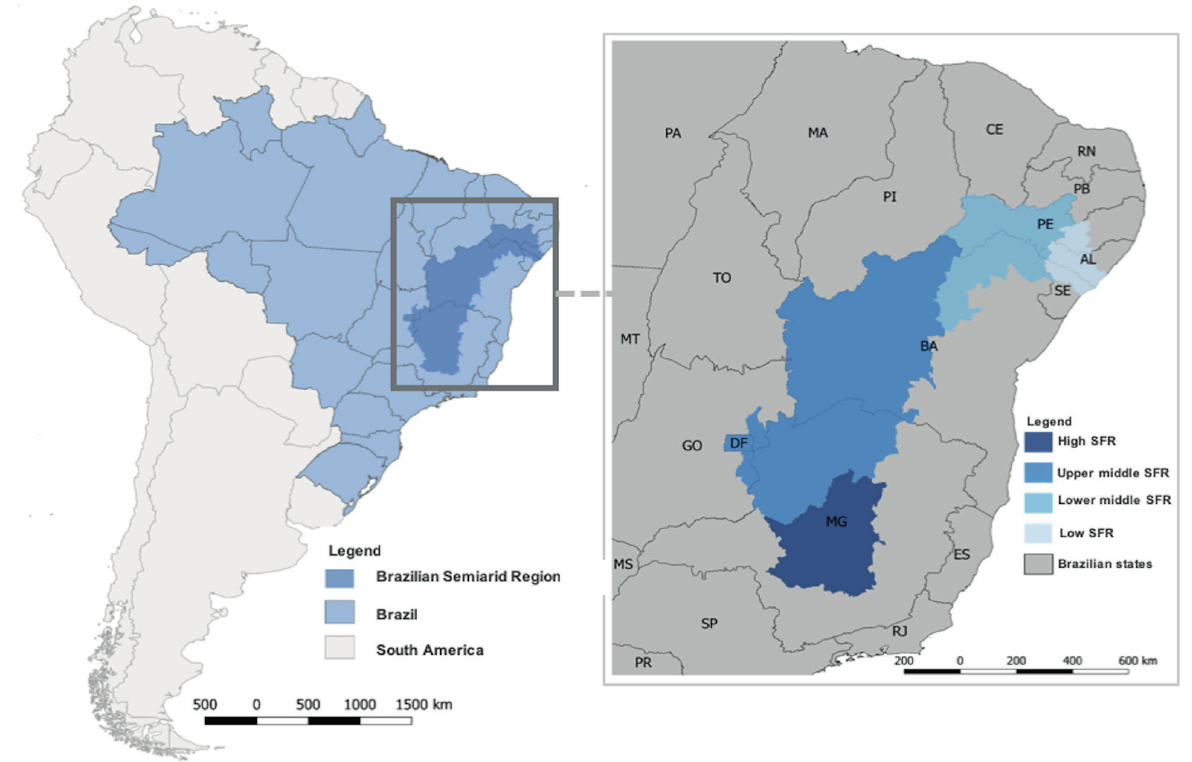
Figure 1 - Geographical location of the San Francisco Basin